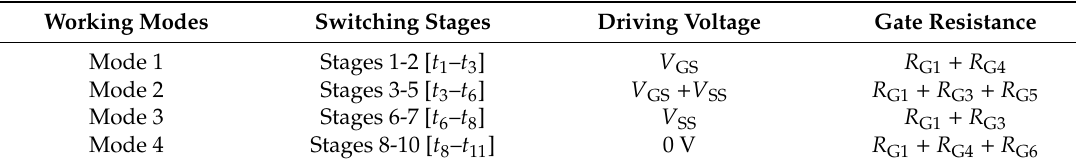
Table 1. Driving voltage and gate resistor in each